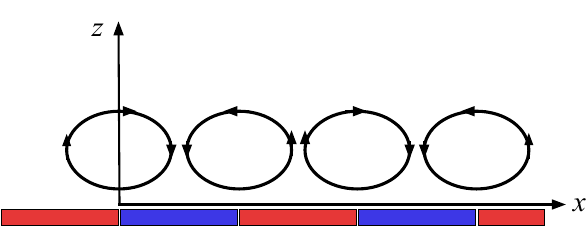
Figure 1. Schematic of two-dimensional ( x , z) thermal convection induced by a surface buoyancy that varies horizontally ( x) as a square wave. Red denotes positive surface buoyancy, blue denotes negative surface